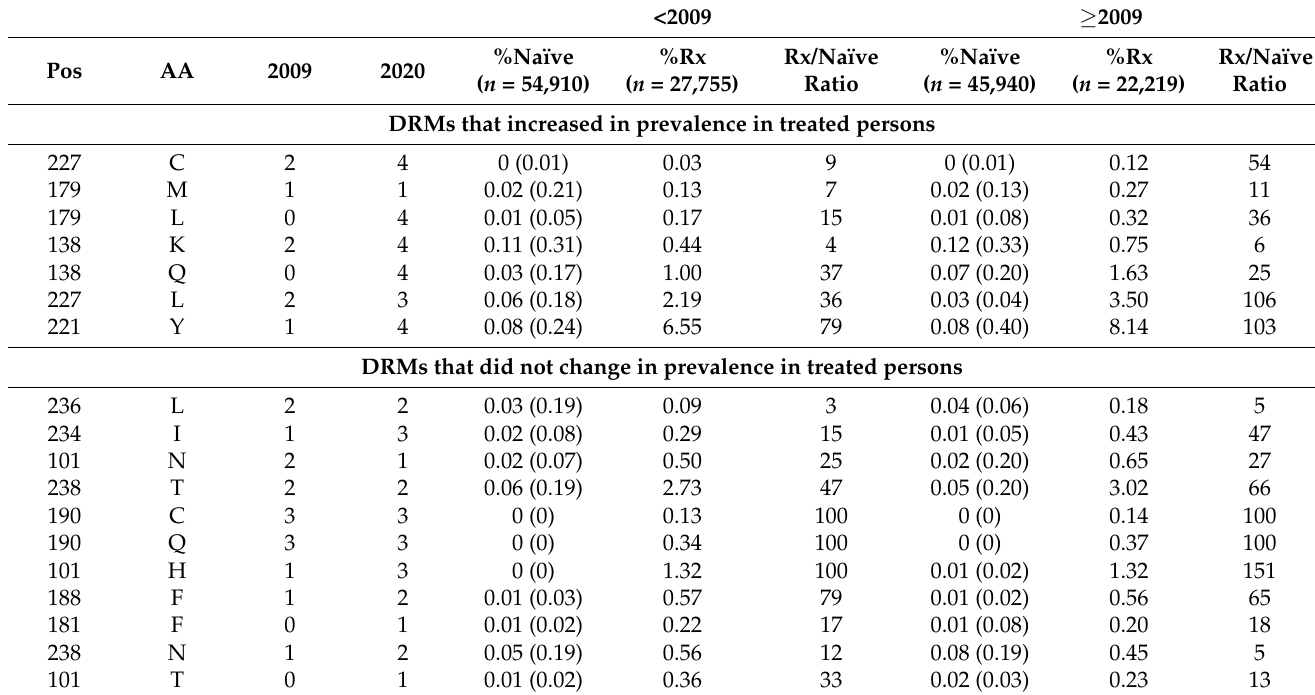
Table 4. Prevalence of Additional Nonpolymorphic NNRTI-Resistance Mutations in RTI-Naïve and NNRTI-Experienced Persons before and after